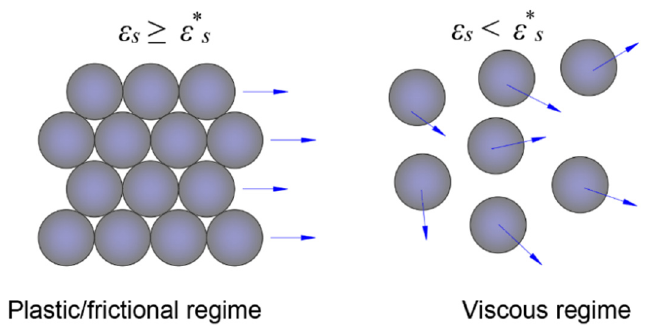
Figure 1. A schematic illustration of the plastic/frictional and viscous flow regimes in the solid phase.